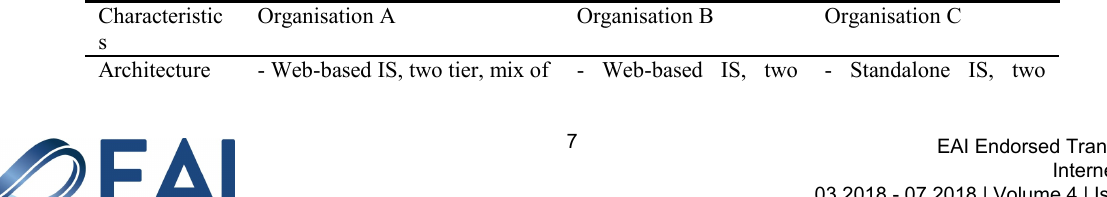
Table 4. Technology dimension in three